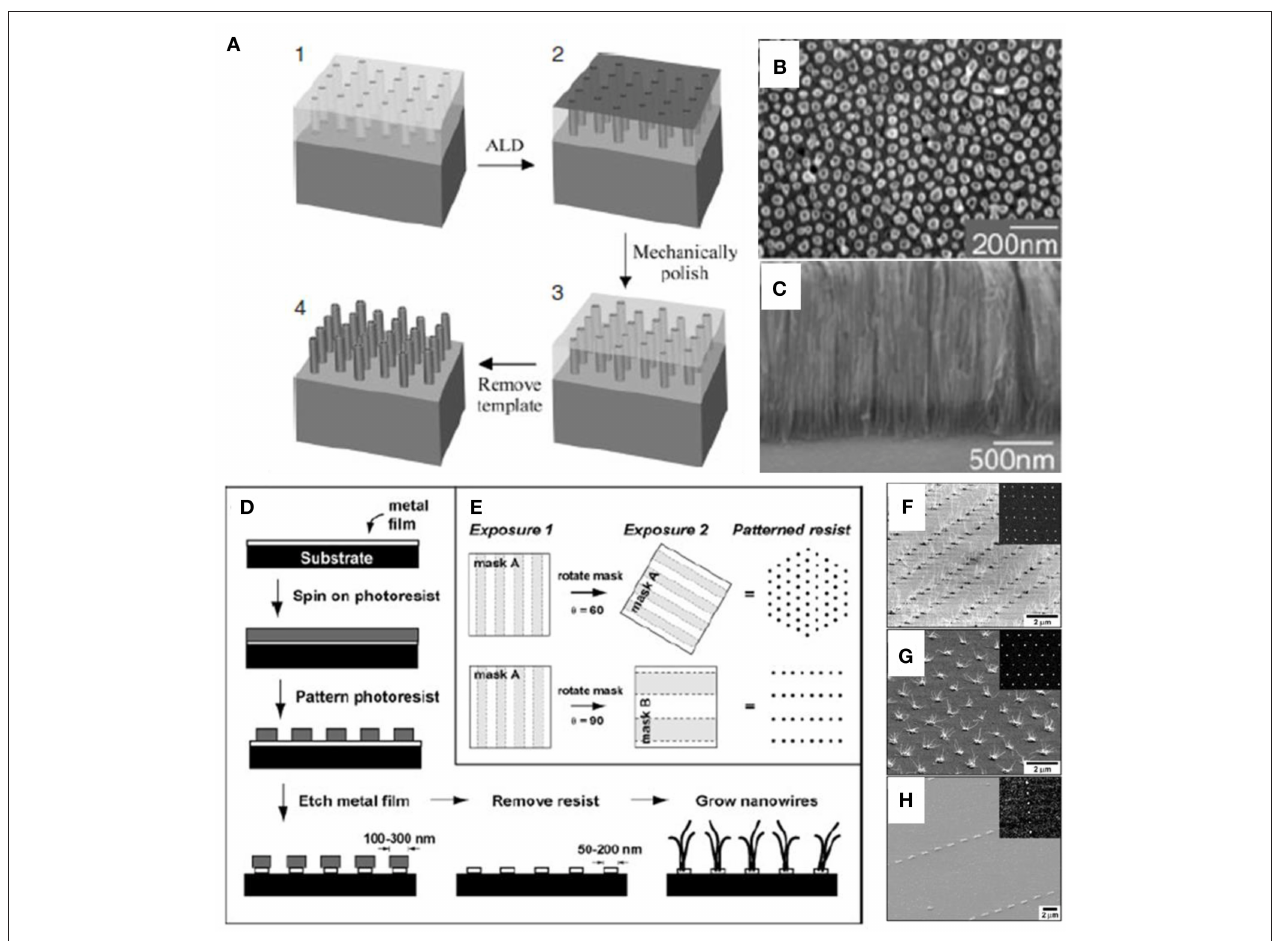
FIGURE 5 | (A) Illustration of creating Titania nanotube arrays on substrate. The SEM images of (B) Top view and (C) side view of nanotubes. Reprinted with permission from Sander et al. (2004), copyright 2004 WILEY-VCH Verlag GmbH & Co. KGaA, Weinheim. The patterning of (D) catalytic gold dots and (E) photoresist posts with different shape and ordering. SEM images of ZnO nanowires arrays grown in (F) square lattice, (G) Hexagonal lattice, and (H) rectangular lattice. Reprinted with permission from Greyson et al. (2004), copyright 2004 WILEY-VCH Verlag GmbH & Co. KGaA,